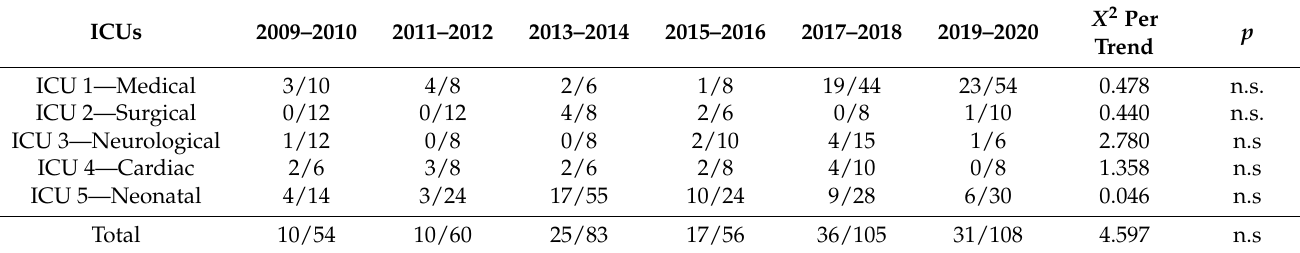
Table 5. Temporal trend of contaminated surface samples in each ICU.